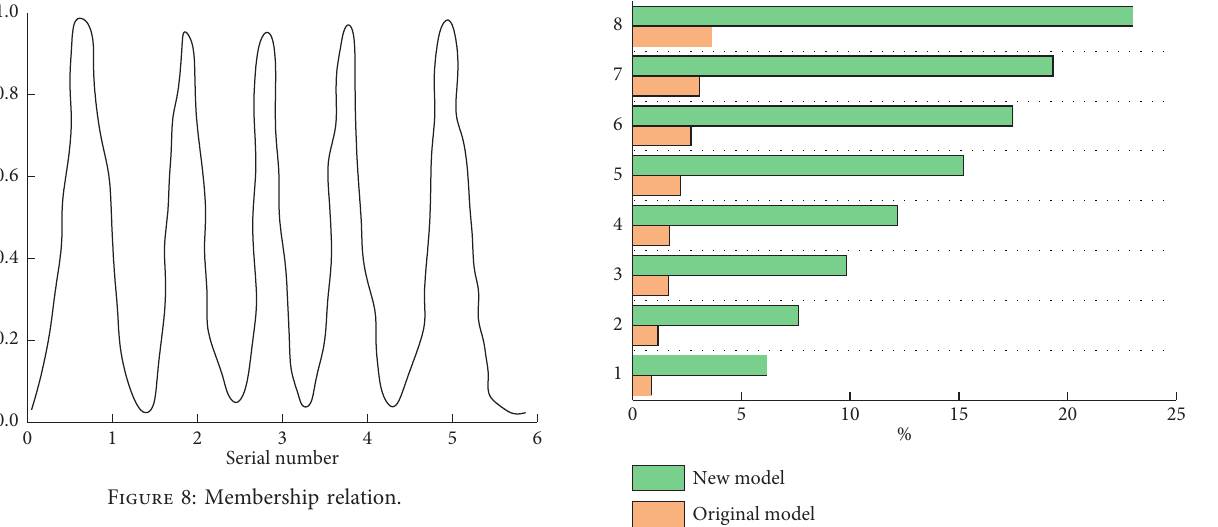
Figure 9: Results